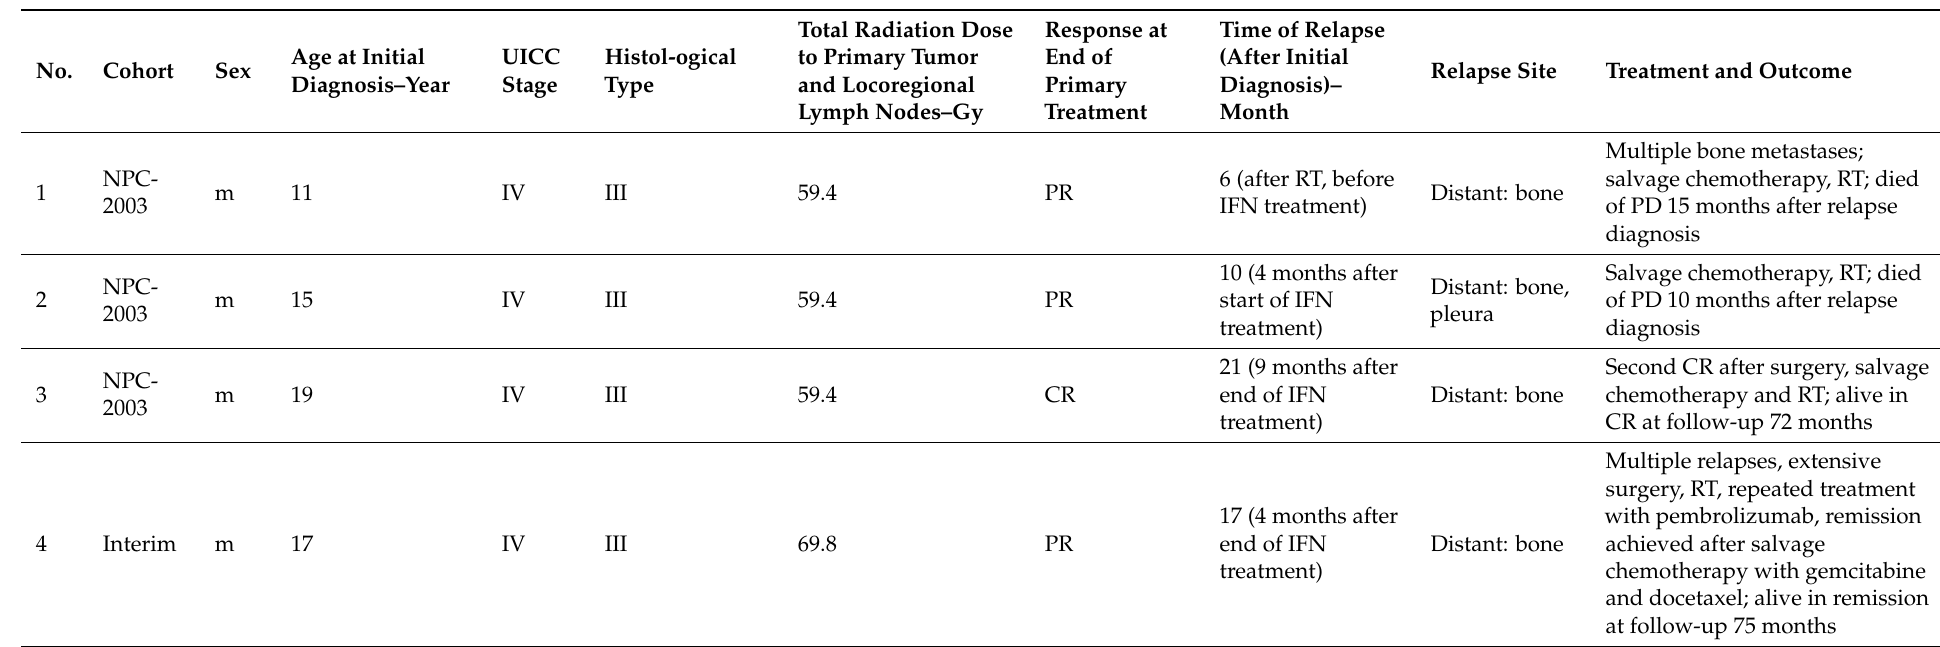
Table 2. Characteristics of patients with